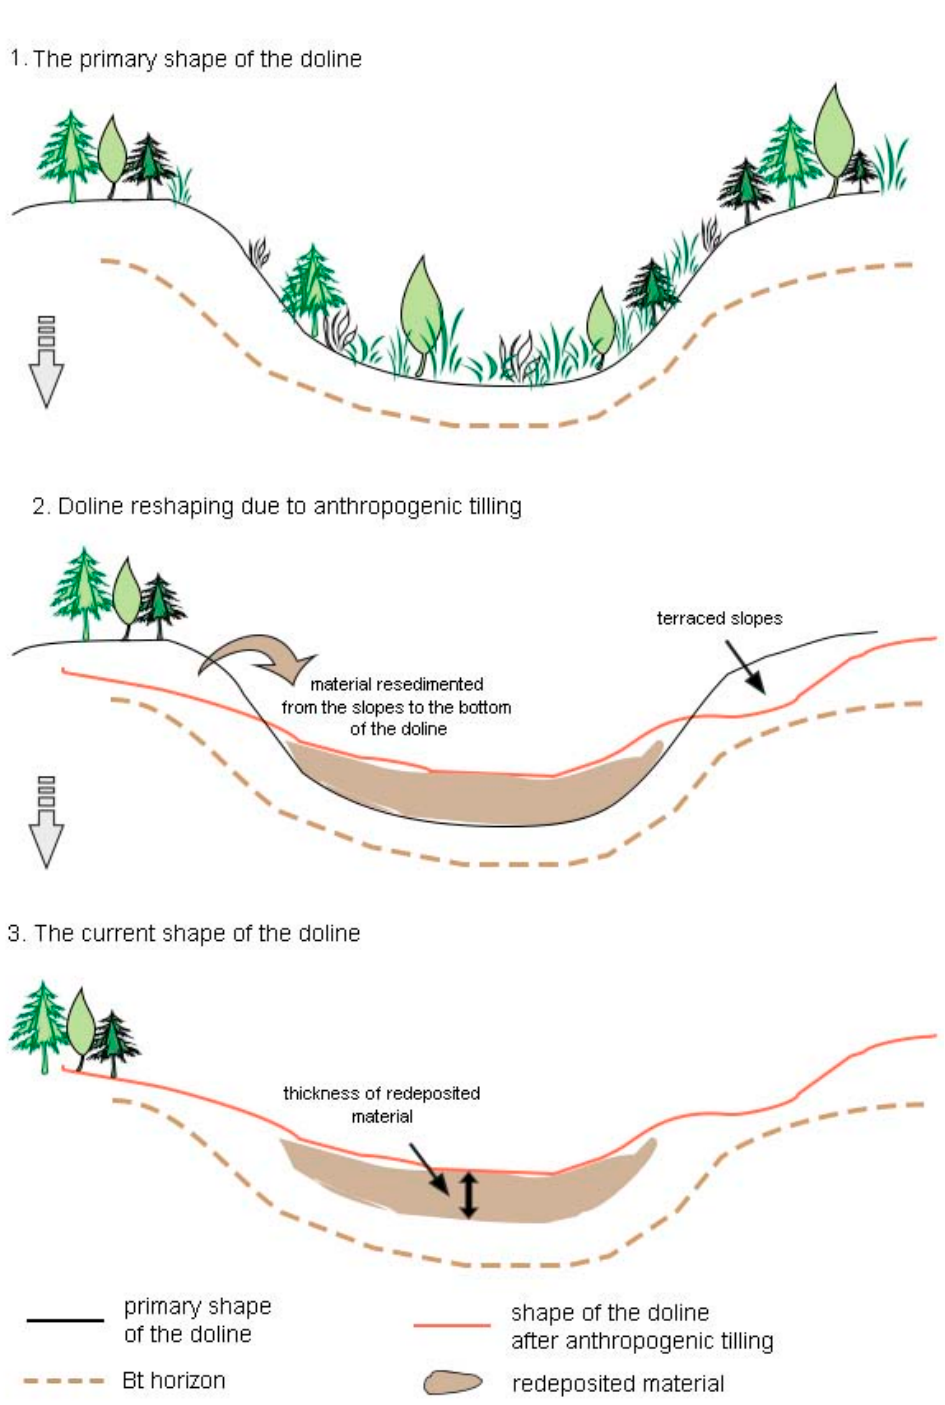
Figure 8. A simplified model of agriculturally reshaped dolines. The Bt horizon in the current form of the doline as detected by the GPR survey indicates the redeposited material.